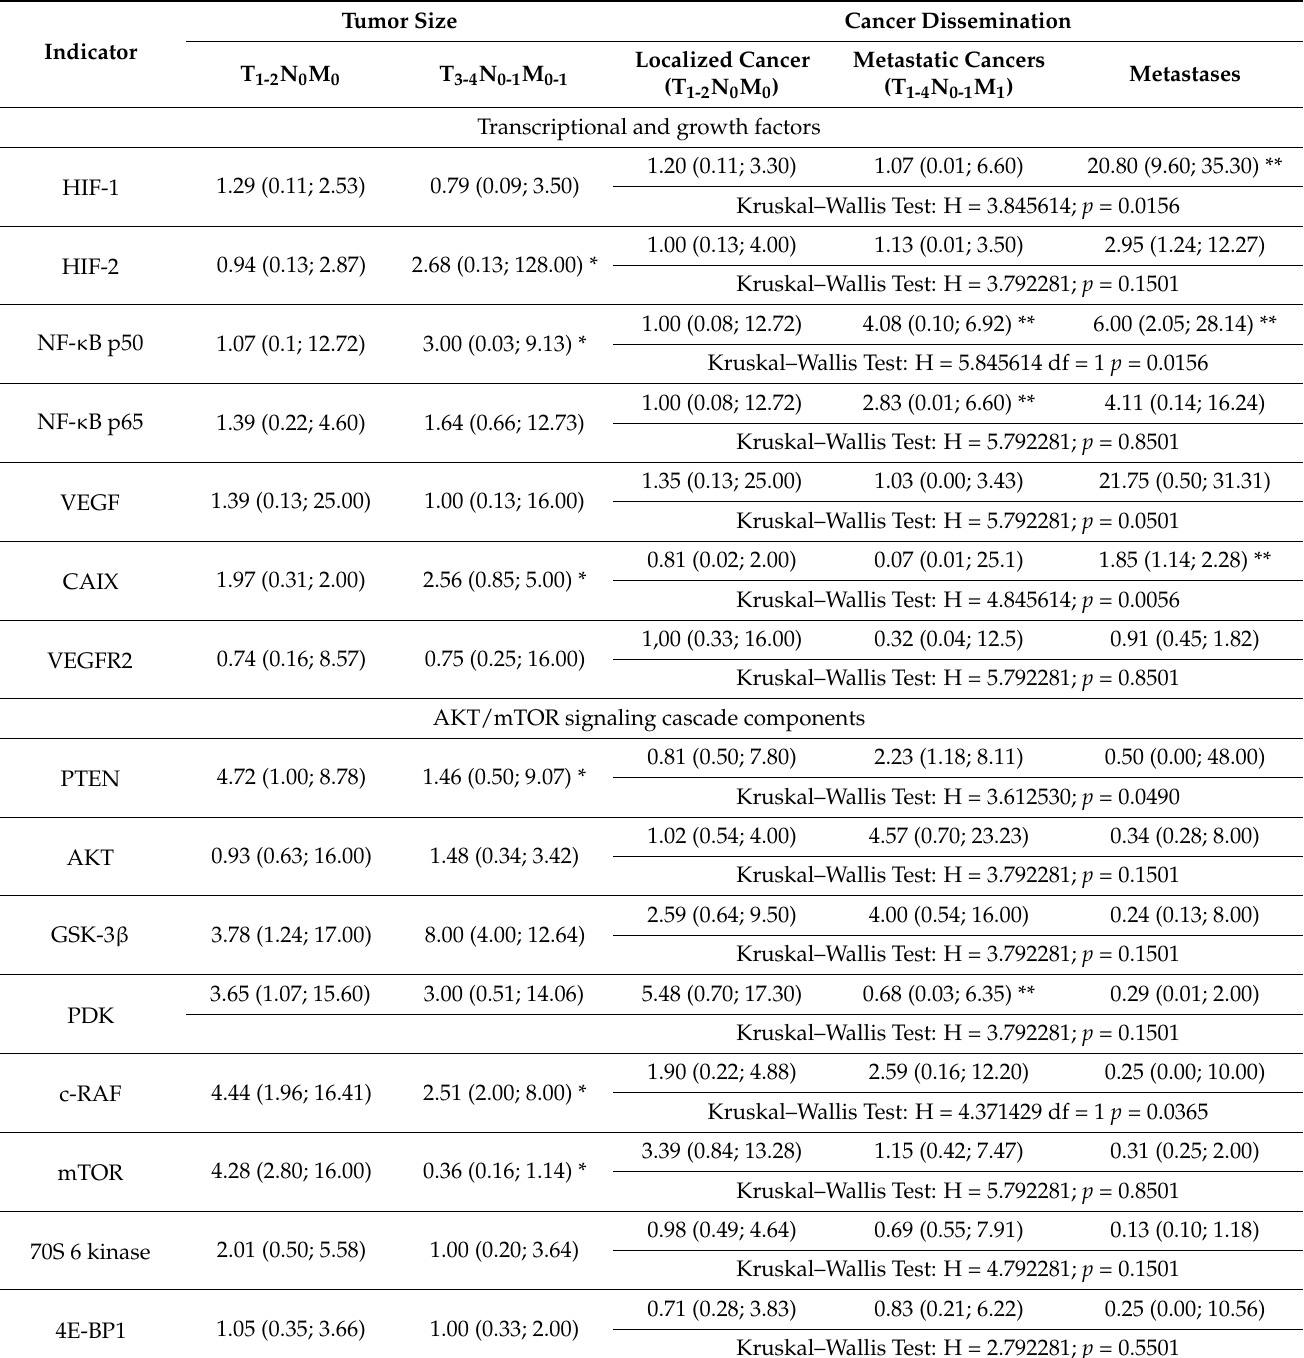
Table 3. Expression of nuclear factors HIF-1, HIF-1, NF- κ Bp50 and NF- κ Bp65, growth factors and components of AKT/m- TOR signaling pathway in tumor tissue of patients depending on tumor size and disease prevalence, Me (Q1;